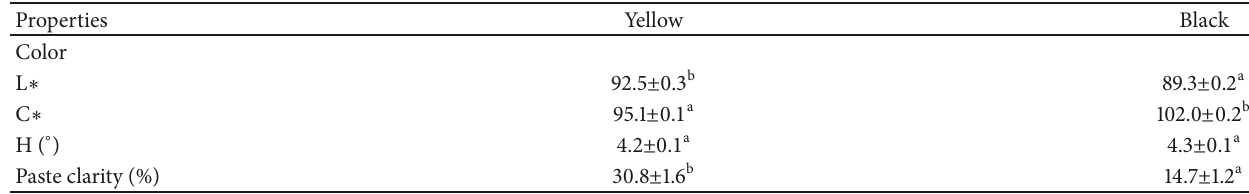
Table 2: Optical properties of starch from two cultivars of